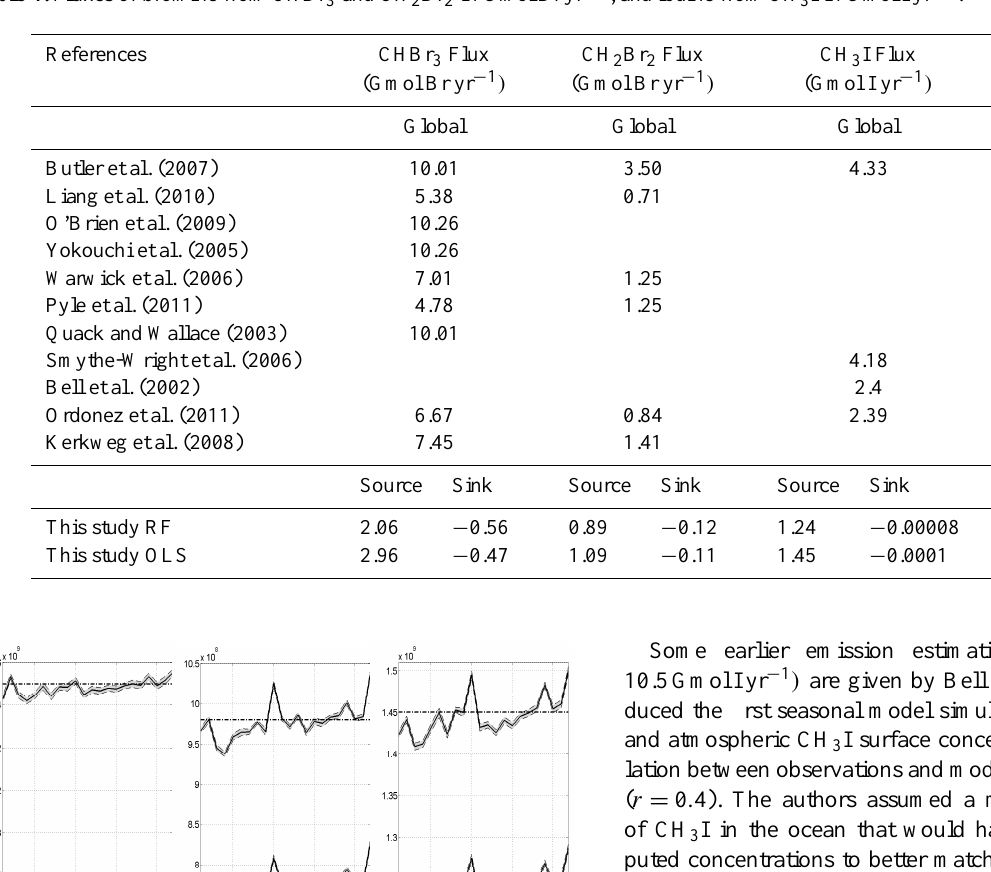
Table 4. Fluxes of bromine from CHBr 3 and CH 2 Br 2 in GmolBryr − 1 , and iodine from CH 3 I in GmolIyr − 1 .